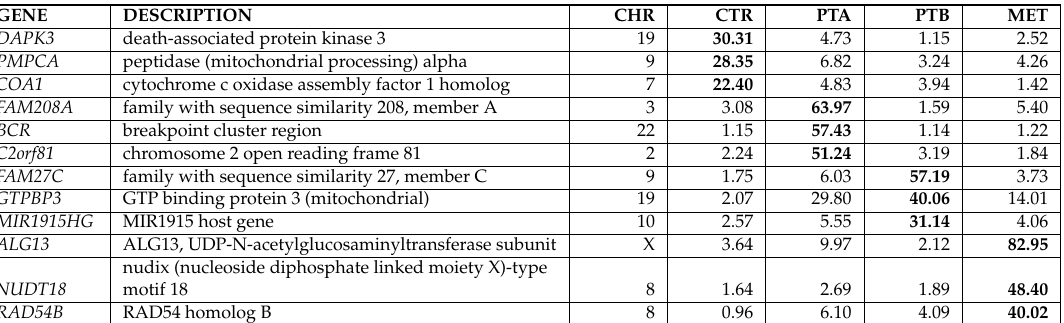
Table 1. Expression data from GSE72304,